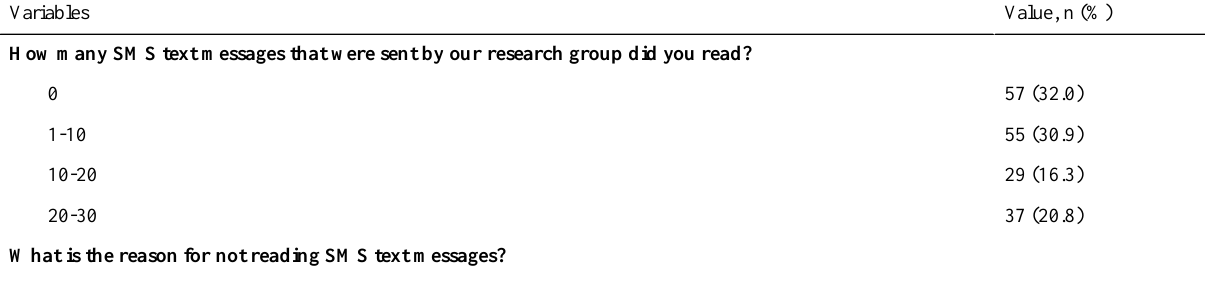
Value, n (%)Variables